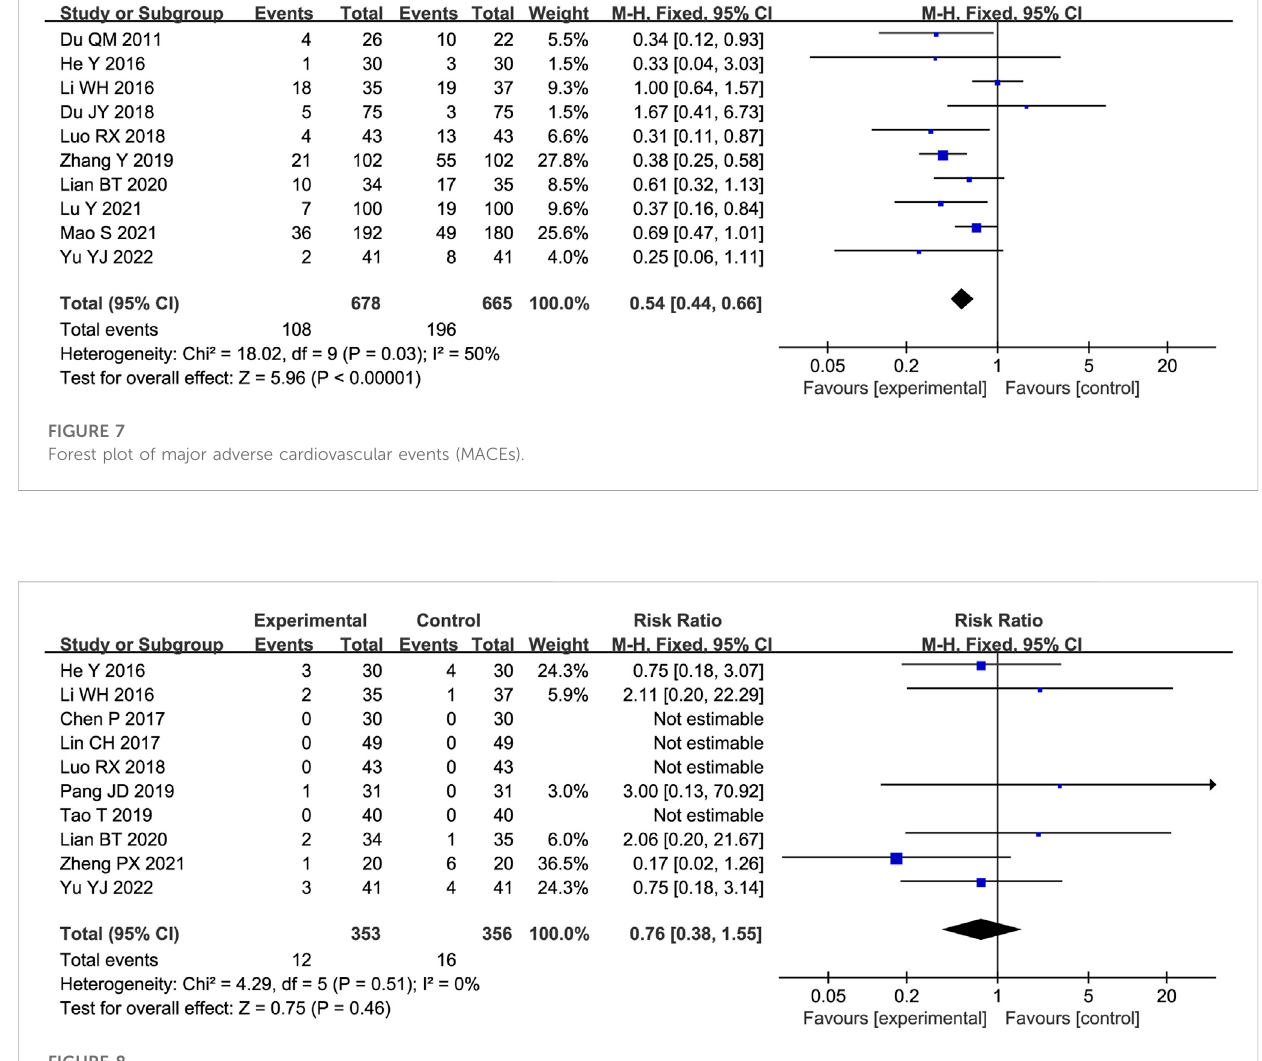
FIGURE 8 Forest plot of major adverse events